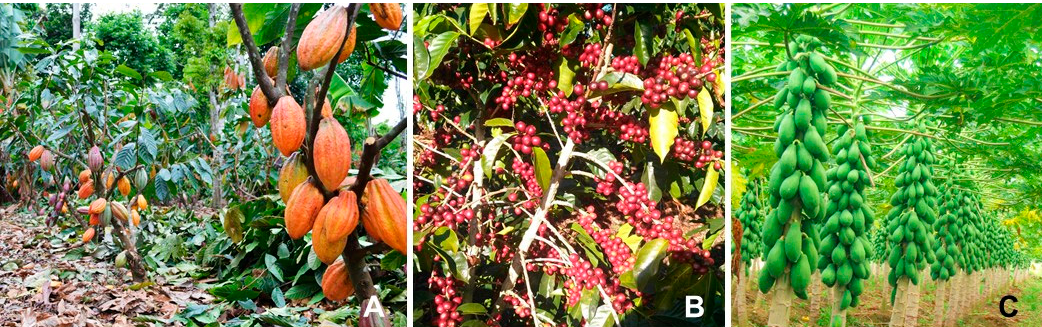
Figure 1. Tropical crops that may be amenable to genome editing and chromosome engineering, as actually grown in Costa Rica. ( A ) Cacao field plot of newly developed, self-compatible variety CATIE-R1 at CATIE, the Tropical Agricultural Research and Higher Education Center (Cartago province, Costa Rica). ( B ) Arabica coffee plants, Catuaí Yellow cultivar (León Cortés county, Costa Rica). ( C ) Papaya, Pococí hybrid (Alajuela province, Costa Rica). Credits, ( A – C ): Allan Mata-Quirós (CATIE, Costa Rica), Emmanuel L ó pez (Passiflora Co ff ee Farm, Costa Rica), Eric Mora–Newcomer (University of Costa